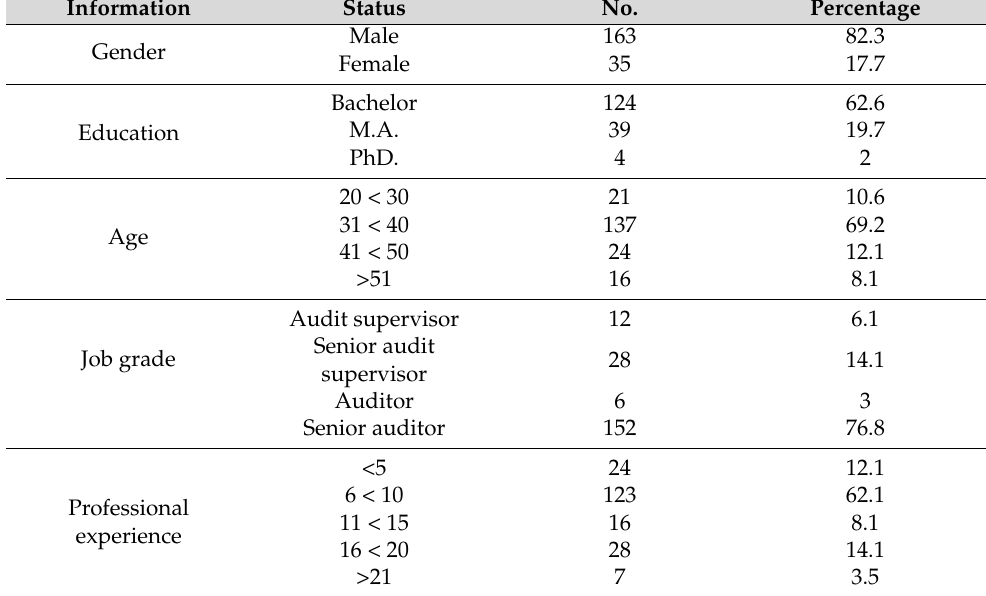
Table 4. The respondents’